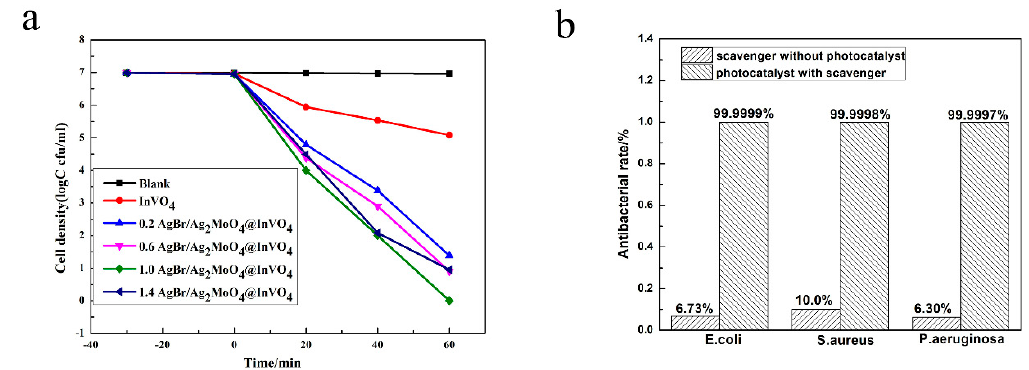
Figure 5. ( a ) Survival curve of Pseudomonas aeruginosa in antibacterial test. ( b ) Inhibition rate of 1.0 AgBr/Ag 2 MoO 4 @InVO 4 photocatalysis to Escherichia coli , Staphylococcus aureus and P. aeruginosa for 60 min under the condition of visible light.